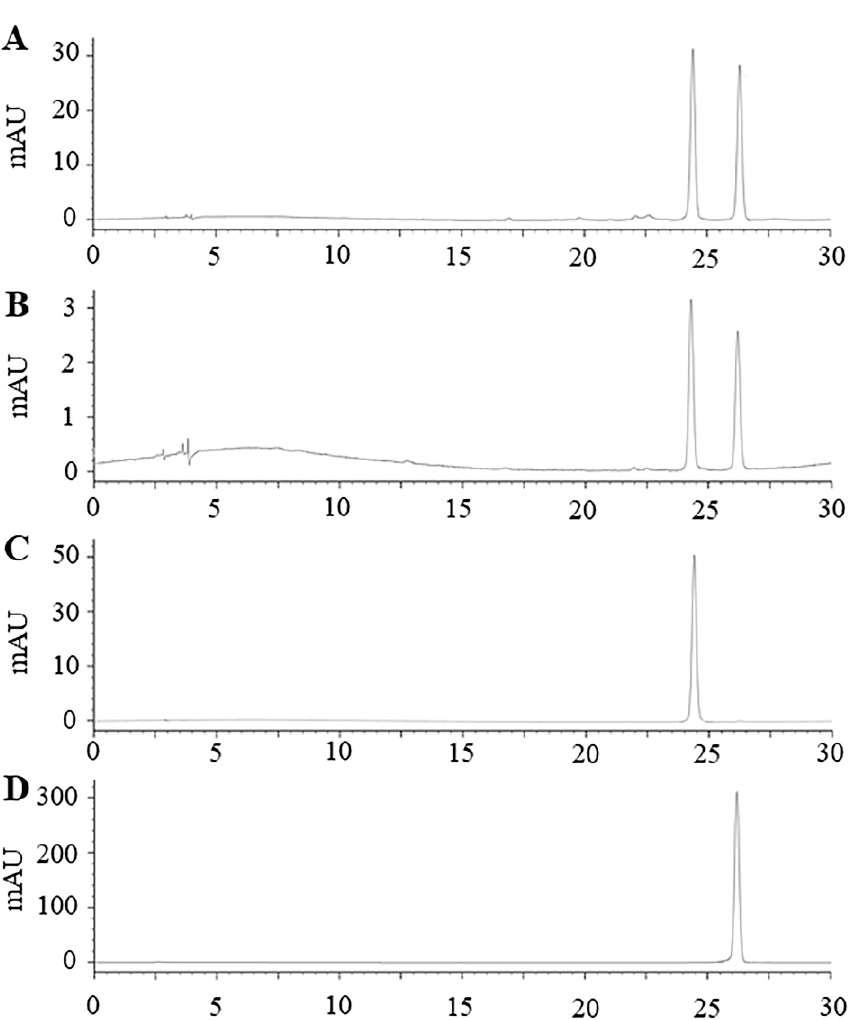
Figure 6. Representative high performance liquid chromatography-diode array detector chromato- graphic profile ( λ = 337 nm) of ( A ) mung bean seed coat extract from laboratory scale; ( B ) mung bean seed coat freeze-dried extract from pilot scale; ( C ) standard vitexin; ( D ) standard isovitexin.